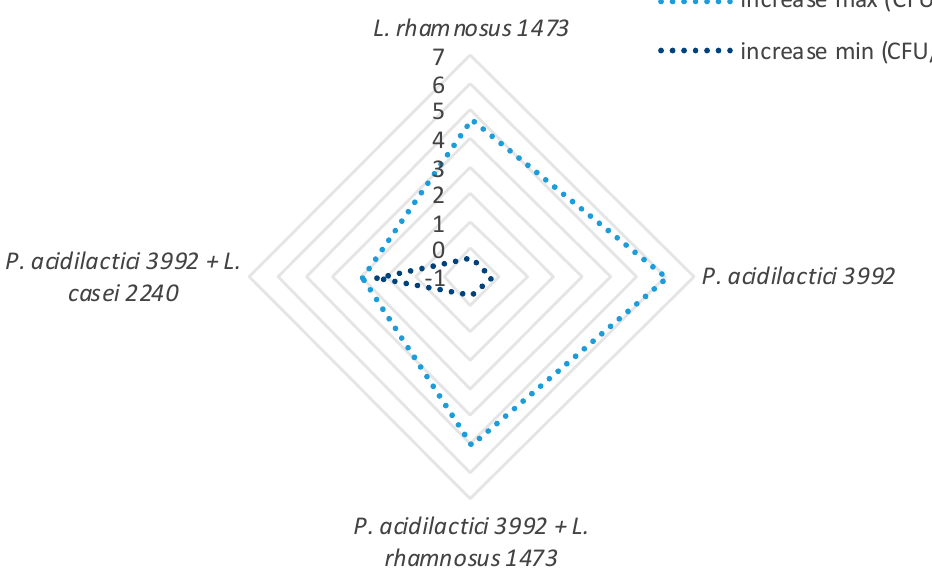
Figure 5. Growth trend of the bacterial strains/co-cultures used. The maximum detected increase is highlighted in light blue and the minimum in dark blue. Bacterial growth is expressed as delta value ( Δ -value), as di ff erences from the initial inoculum size and fi nal concentration (from − 1 to 7 Log CFU/mL).